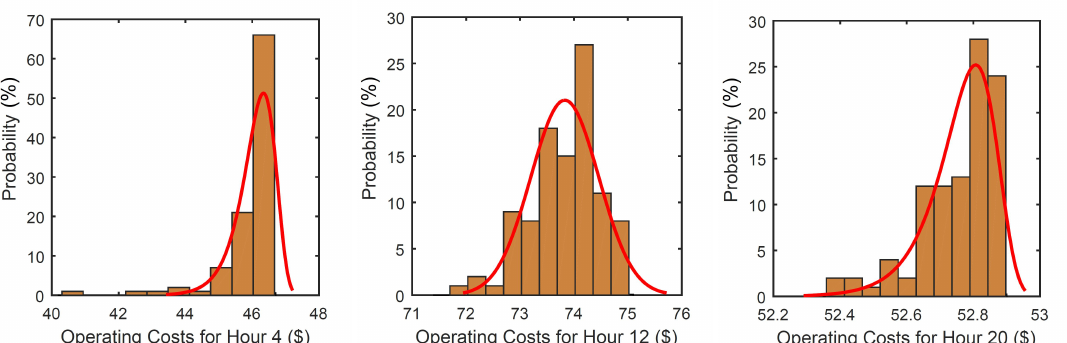
Figure 11. Probability of the operating cost on the 4th hour ( left ), 12th hour ( center ), and 20th hour ( right ) of the 22 September case study.